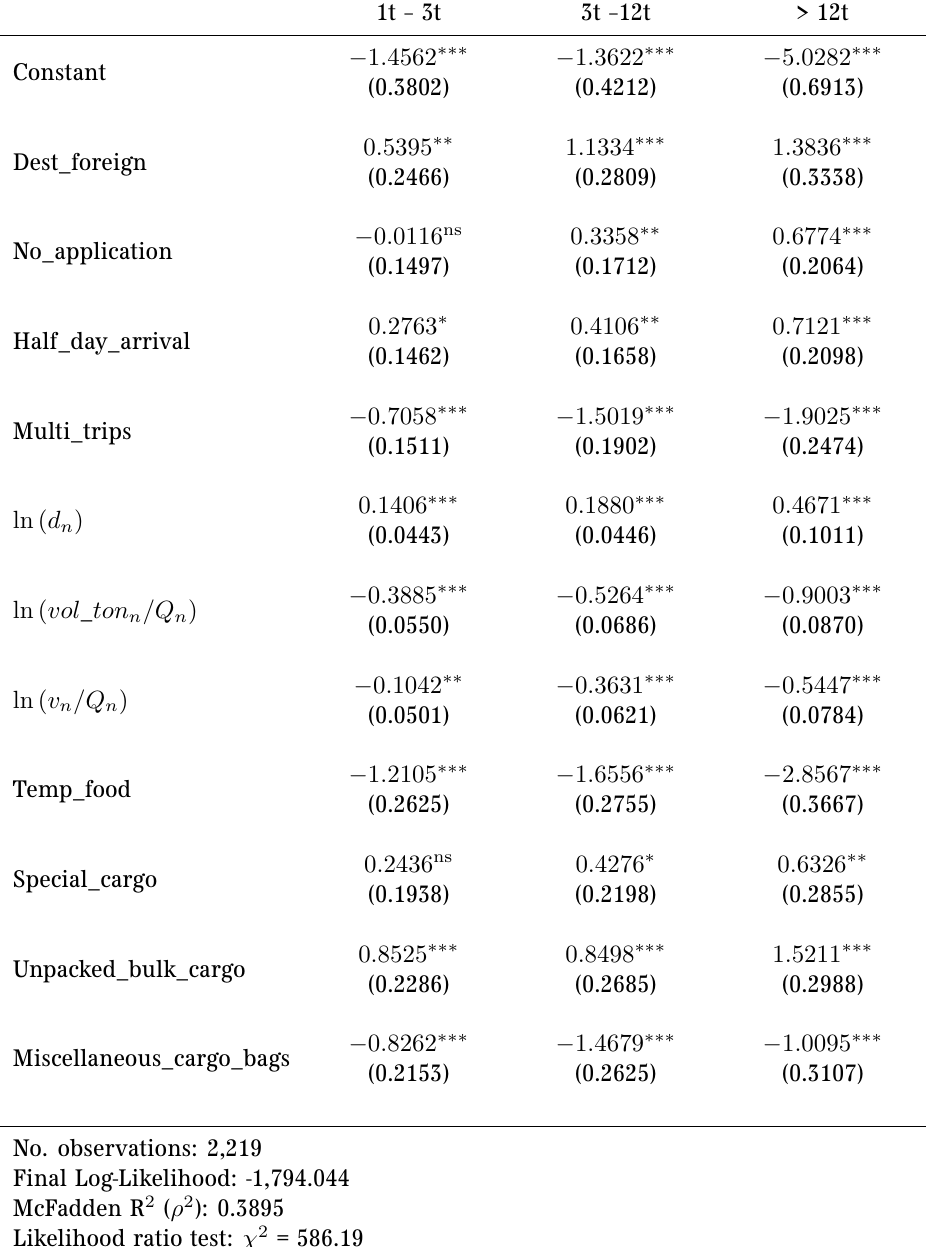
Table 7: Discrete shipment size choice model with latent